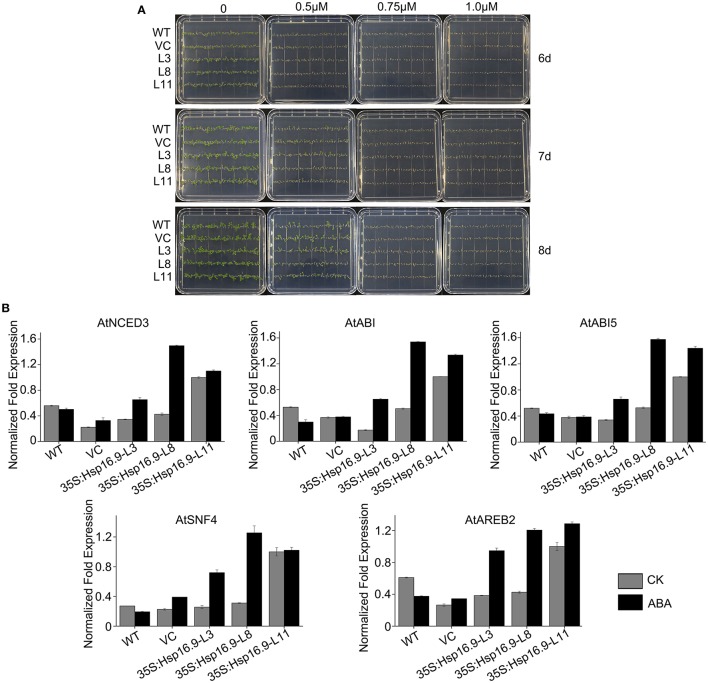
Germination and greening rates of WT, VC and transgenic plants in response to abscisic acid (ABA). (A) Seed germination of WT, VC, and MsHSP16.9 transgenic (TG) plants subjected to 0, 0.5, 0.75, and 1.0 μM ABA at 6, 7, and 10 days after treatment. (B) Expression profiles of genes involved in ABA biosynthesis and catabolism in WT and MsHSP16.9 transgenic plants.